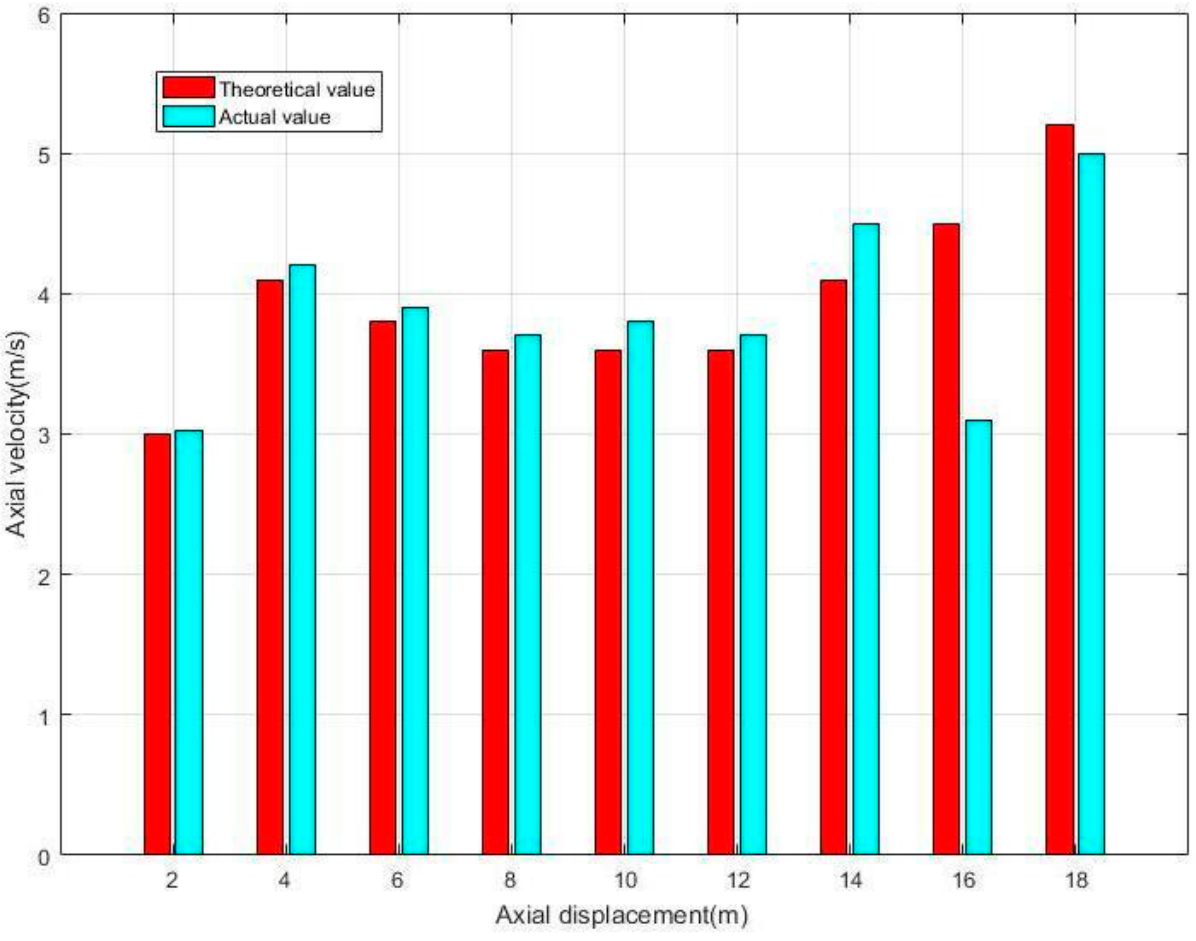
Figure 12. Comparison of the theoretical and experimental values of the axial velocity of the fuel element.